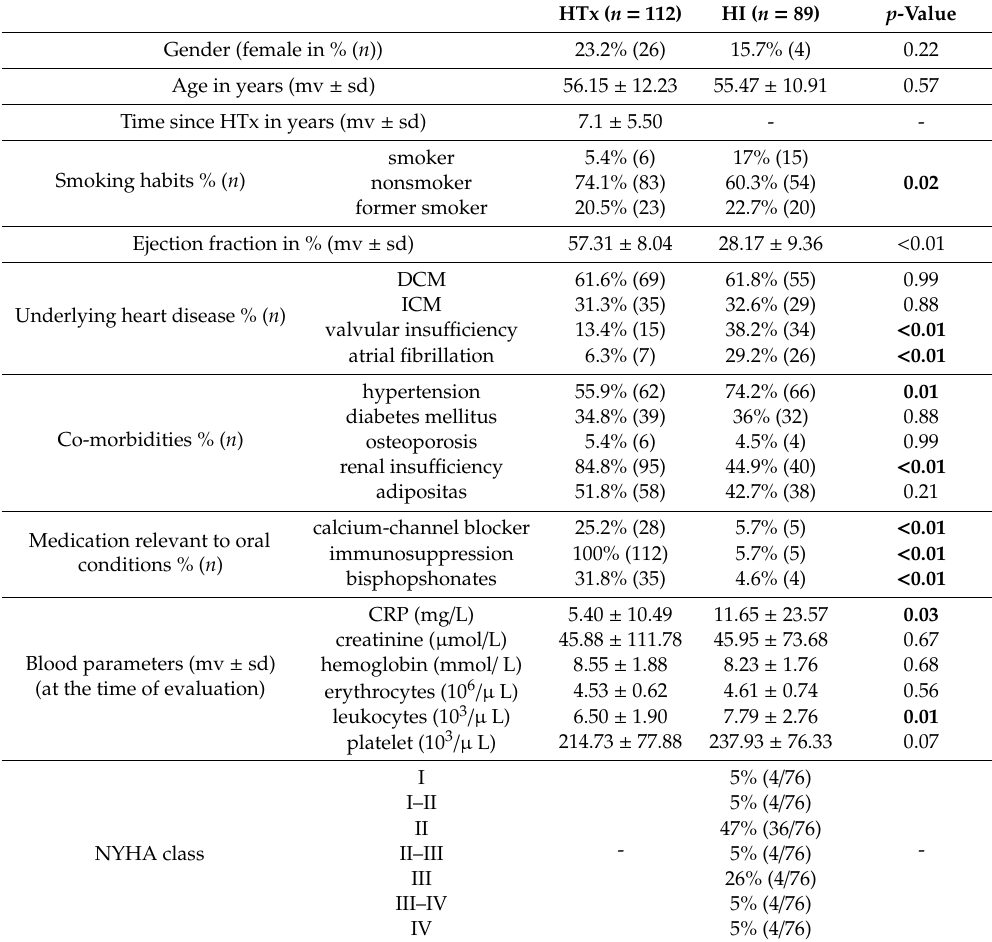
Table 1. Patient characteristics, significance level: p <